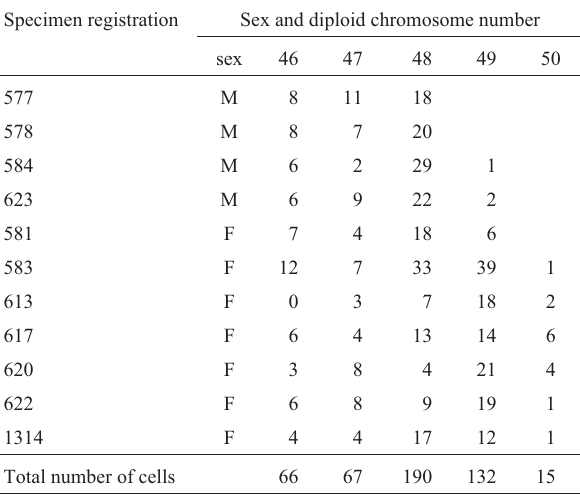
Table 1 - Chromosome number frequency found in Astyanax eigenmanniorum from the Caetano